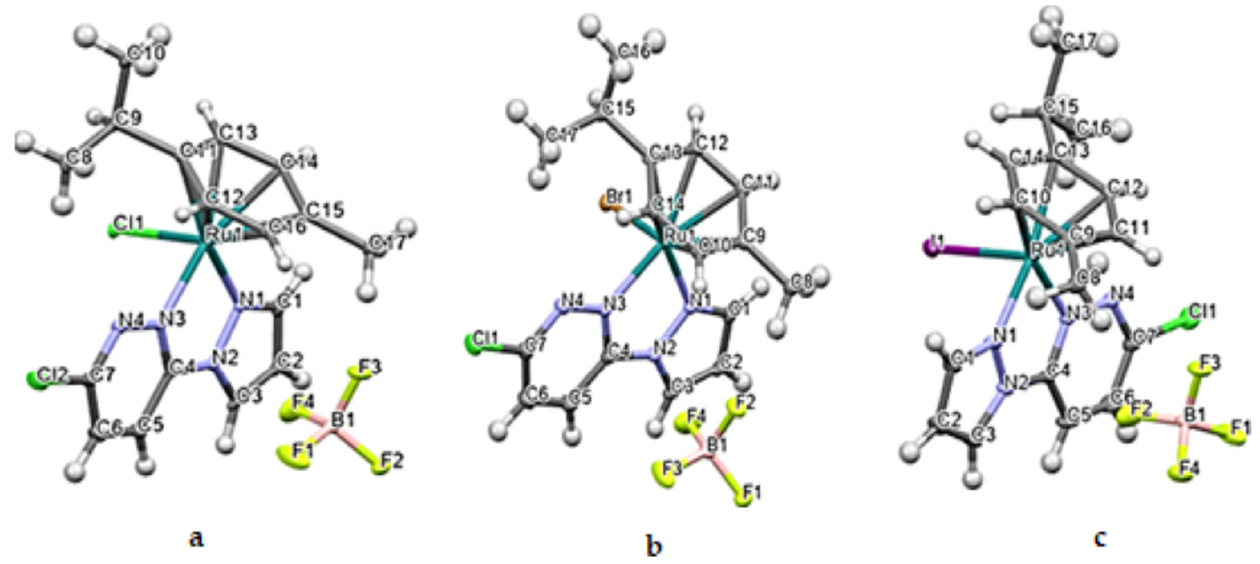
Figure 1. The Ortep diagrams of the Ru(II) complexes, [( η 6 - p -cymene)(3-chloro-6-(1H-pyrazol-1-yl)pyridazine)Ru(X)]BF 4 , ( a ) Ru1 (X = Cl); ( b ) Ru2 (X = Br); ( c ) Ru3 (X = I), showing their asymmetric units. The displacements of atoms are shown at the 50% probability level.